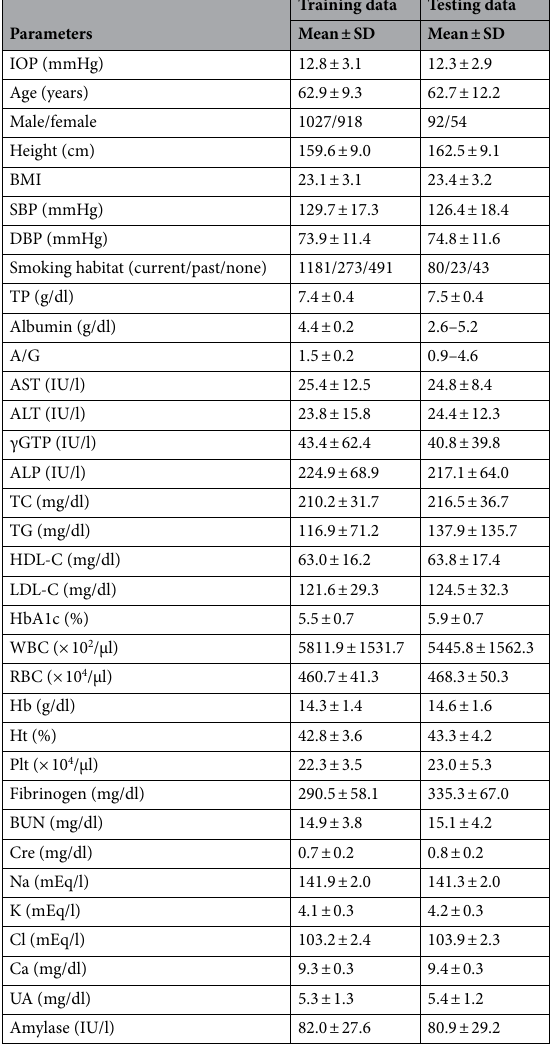
Table 1. Subjects’ demographic data. IOP intraocular pressure, SD standard deviation, BMI body mass index, SBP systolic blood pressure, DBP diastolic blood pressure, TP total protein, A/G albumin/globulin, AST aspartate aminotransferase, ALT alanine aminotransferase, γGTP guanosine triphosphate, ALP alkaline phosphatase, HDL-C high-density lipoprotein cholesterol, LDL-C low-density lipoprotein cholesterol,